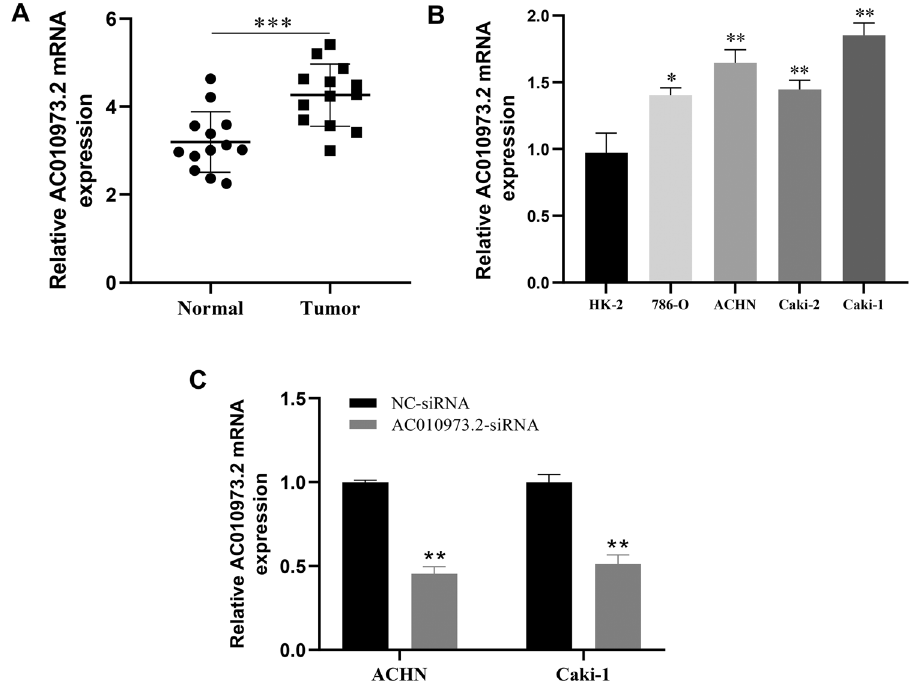
Figure 6. Upregulation of AC010973.2 mRNA expression in ccRCC. Notes: ( A ) AC010973.2 mRNA expression in tumors and non-malignant tissues from ccRCC patients. ( B ) AC010973.2 mRNA expression in ccRCC cell lines and normal renal tubular epithelial cells. ( C ) mRNA expression in AC010973.2 knockdown cell